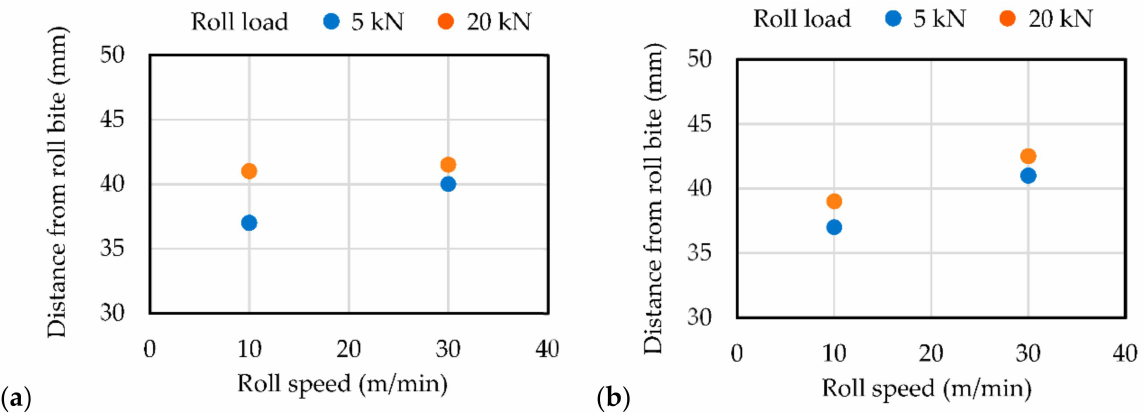
Figure 7. Effects of roll materials on solidification starting point, expressed as distance from roll bite. The rolling speed was 10 or 30 m/min, and the roll load was 5 or 20 kN. ( a ) Mild steel roll and ( b ) copper